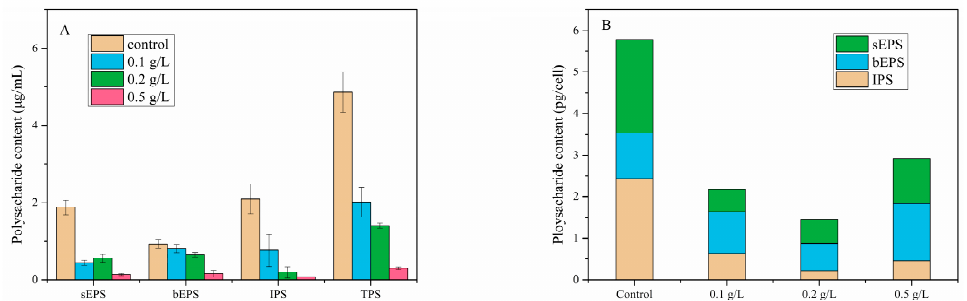
Figure 8. ( A ) Polysaccharide content and ( B ) polysaccharide fraction per cell on 10th day after various concentrations of MC added.